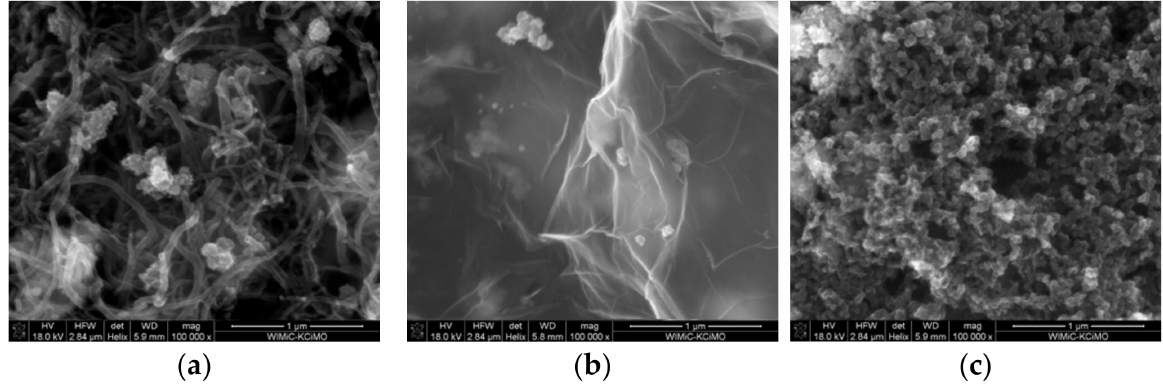
Figure 2. SEM scans of ( a ) NT + RuO 2 , ( b ) GR + RuO 2 , and the ( c ) CB + RuO 2 layer.